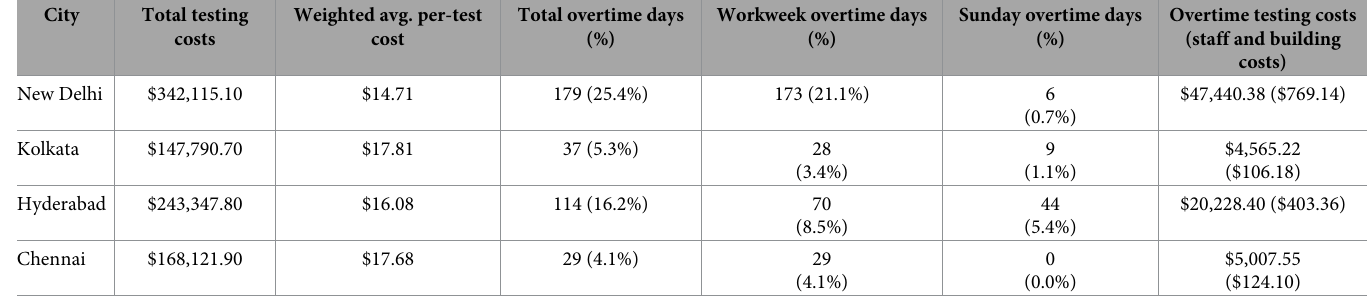
Table 1. Total per-test unit costs during the experiment, weighted to account for actual different unit costs by workloads, and costs associated with overtime work and laboratory operations to meet same-day testing.